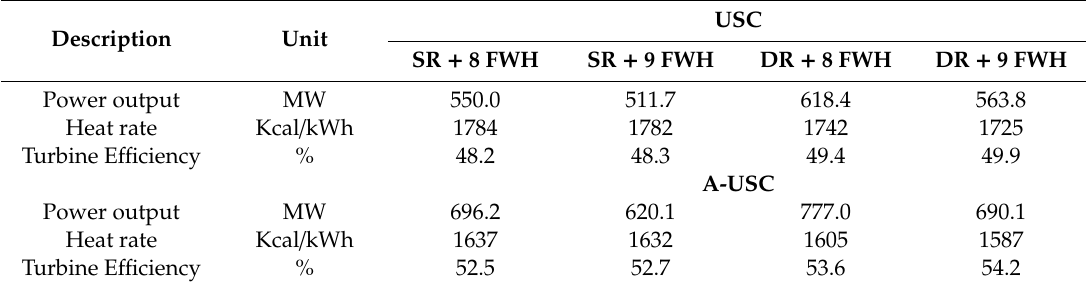
Table 6. The output and heat rate of the USC & A-USC simulation